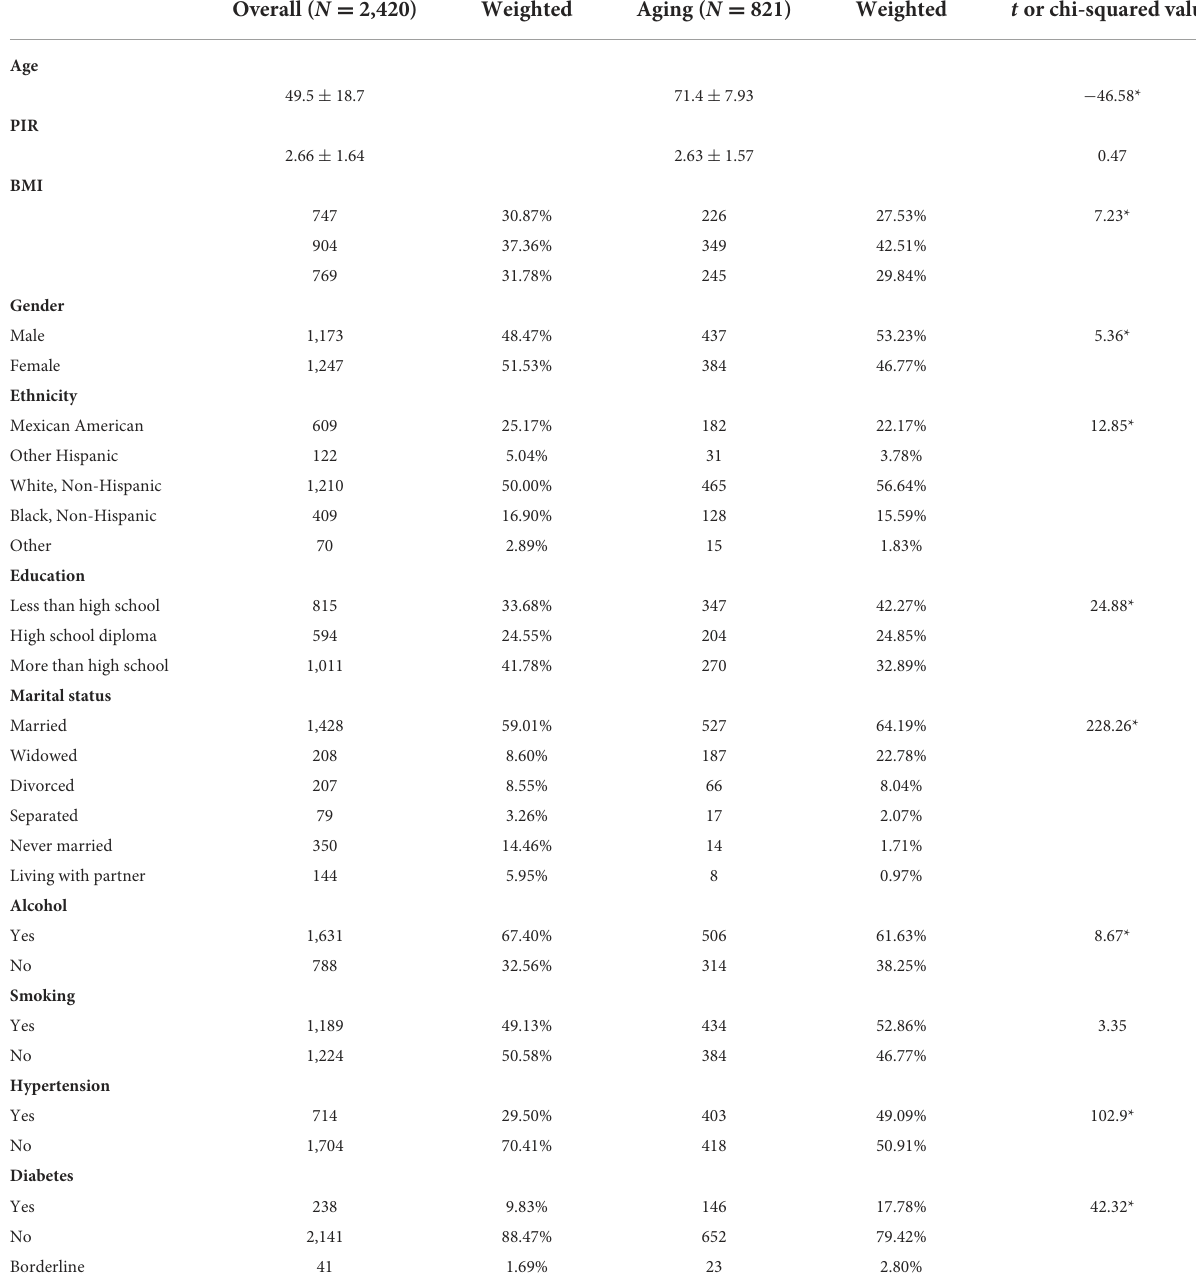
TABLE 1 Comparison between overall and aging population in weighted characteristics of the NHANES 1999–2002. Overall ( N = 2,420) Weighted Aging ( N = 821)